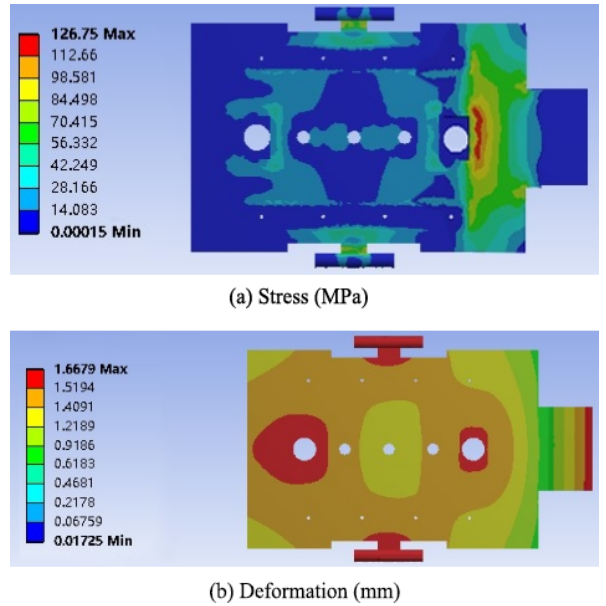
Figure 8. The cloud diagrams of the stress and deformation of the rear frame.